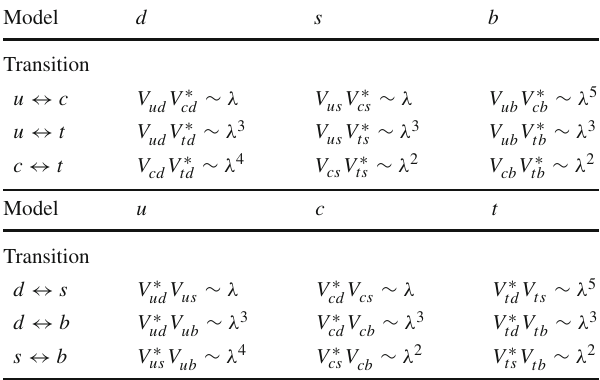
Table 1 CKM suppression in FCNC transitions in BGL models